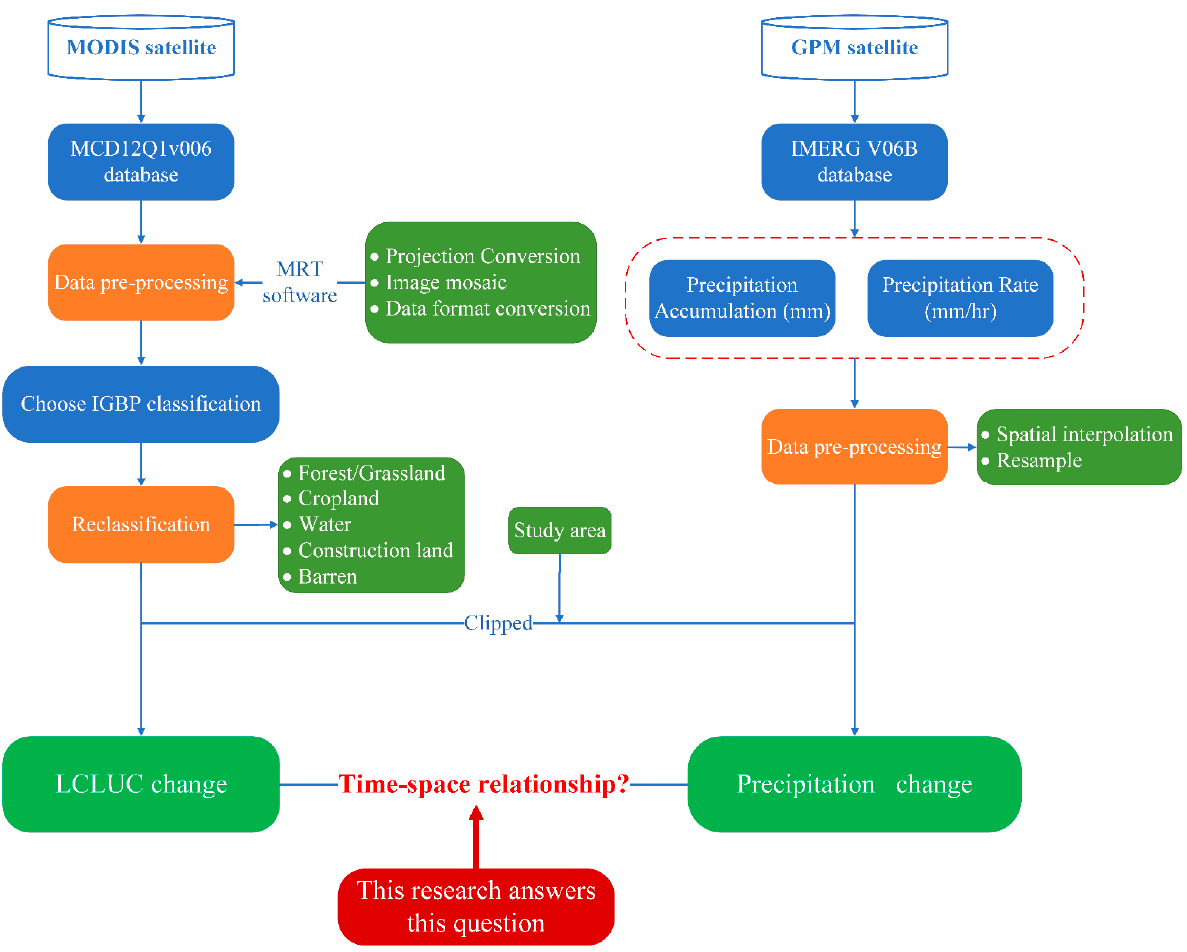
Figure 2. Methodological workflow.